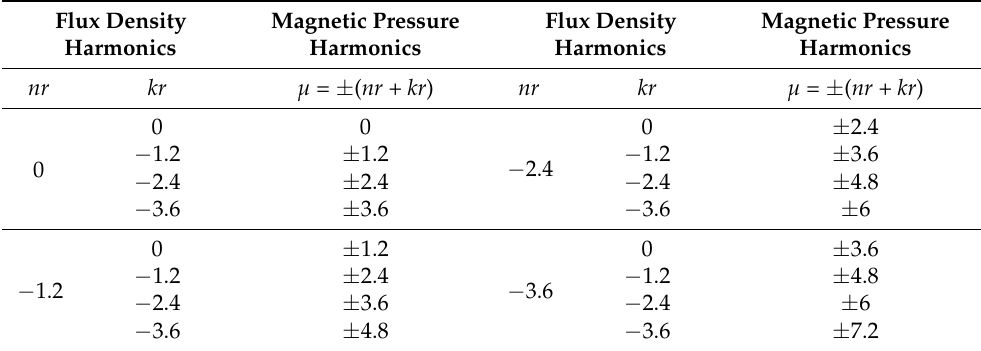
Table 7. Relationship between the harmonics of the flux density and the harmonics of the magnetic pressure created by the armature of the Qs36p15 machine on the rotor